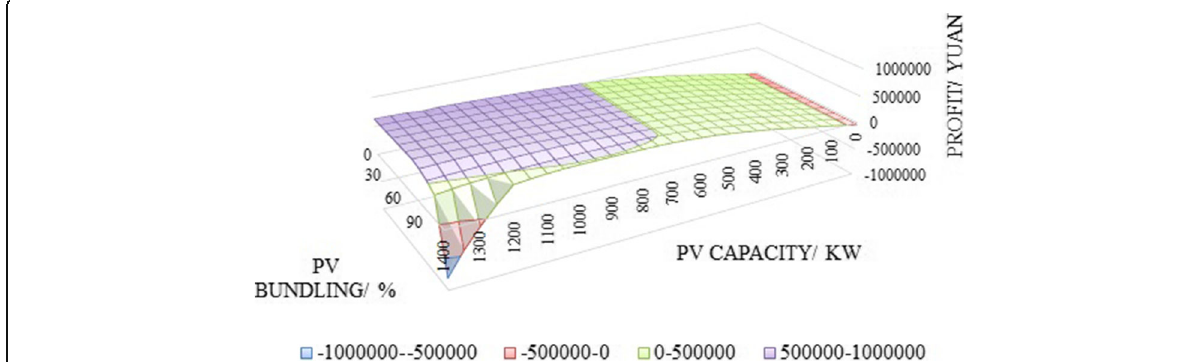
Fig. 12 Profit value surface with different PV capacities and bundling requirements